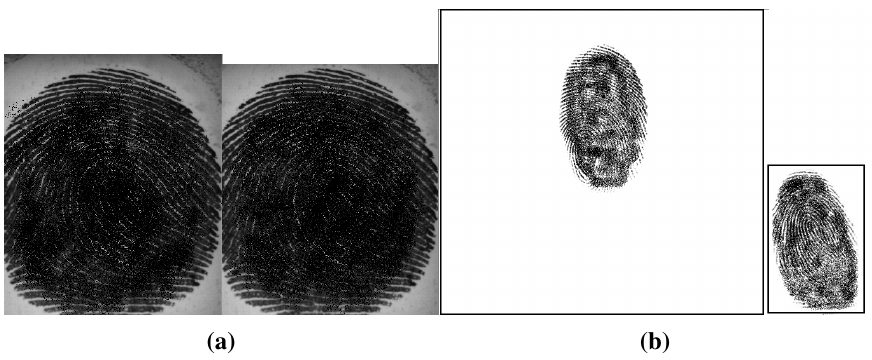
Examples of the result obtained by the segmentation method (images were degraded for privacy purposes). ( a ) Pair of original and segmented